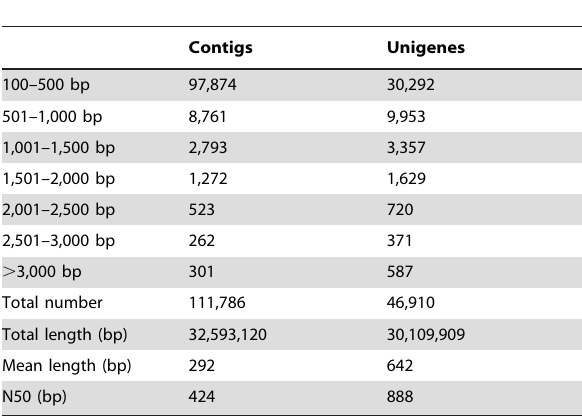
Table 1. Summary of assembled contigs and unigenes.